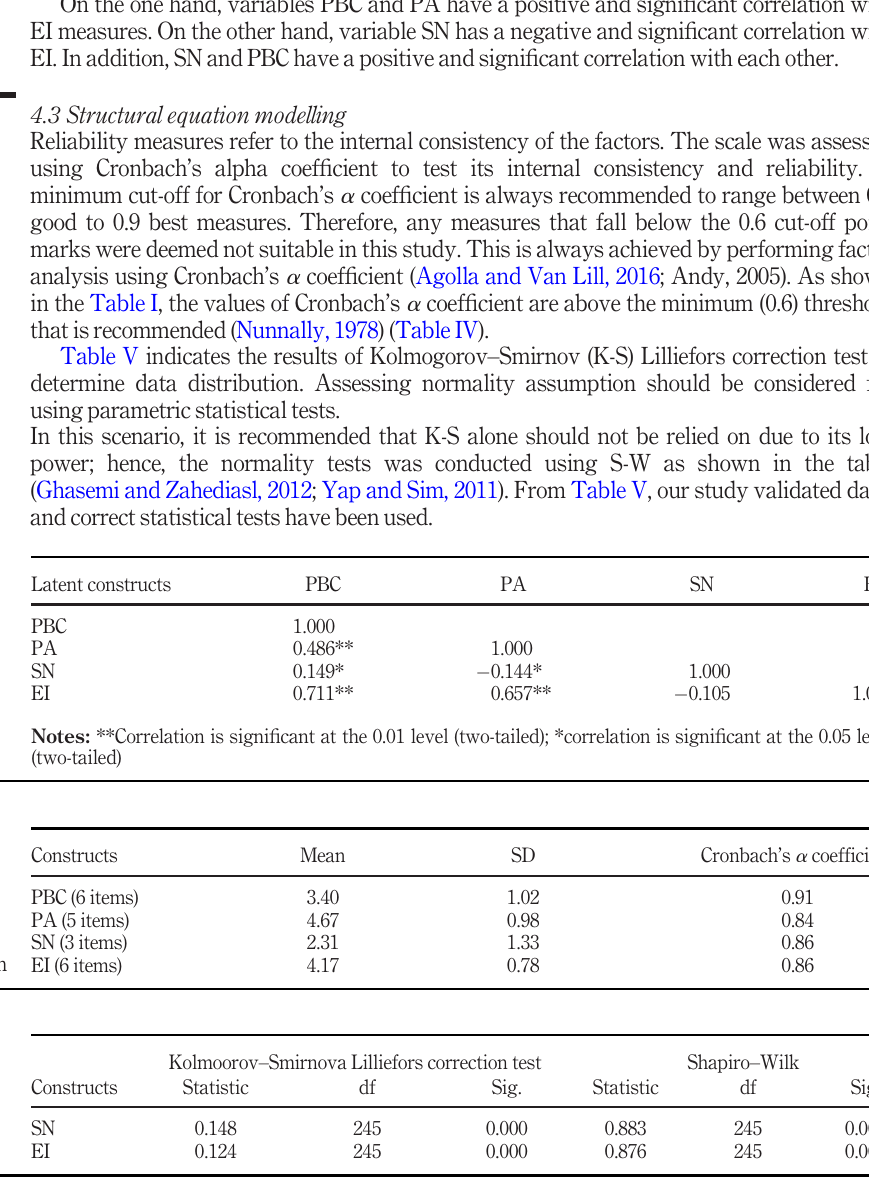
Table V. Tests of normality